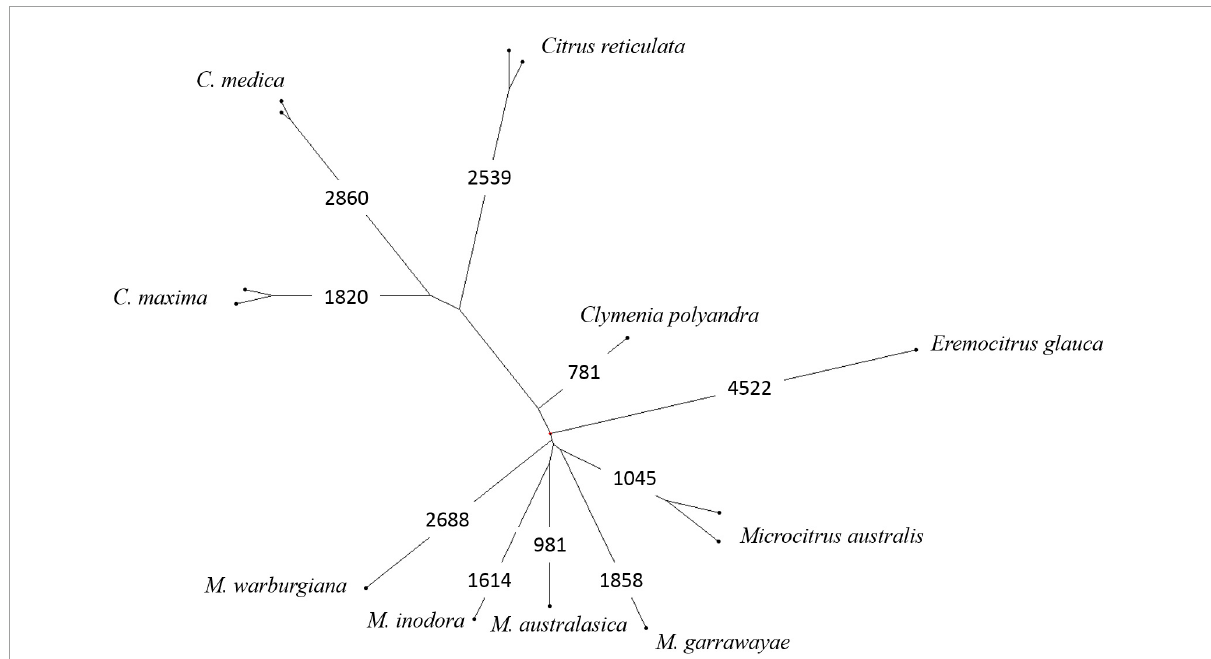
FIGURE6 Organization of the nuclear diversity of 10 Asian and Oceanian species; NJ tree analysis from the genotyping of 49,187 diallelic SNPs and number of DSNPs for each species.